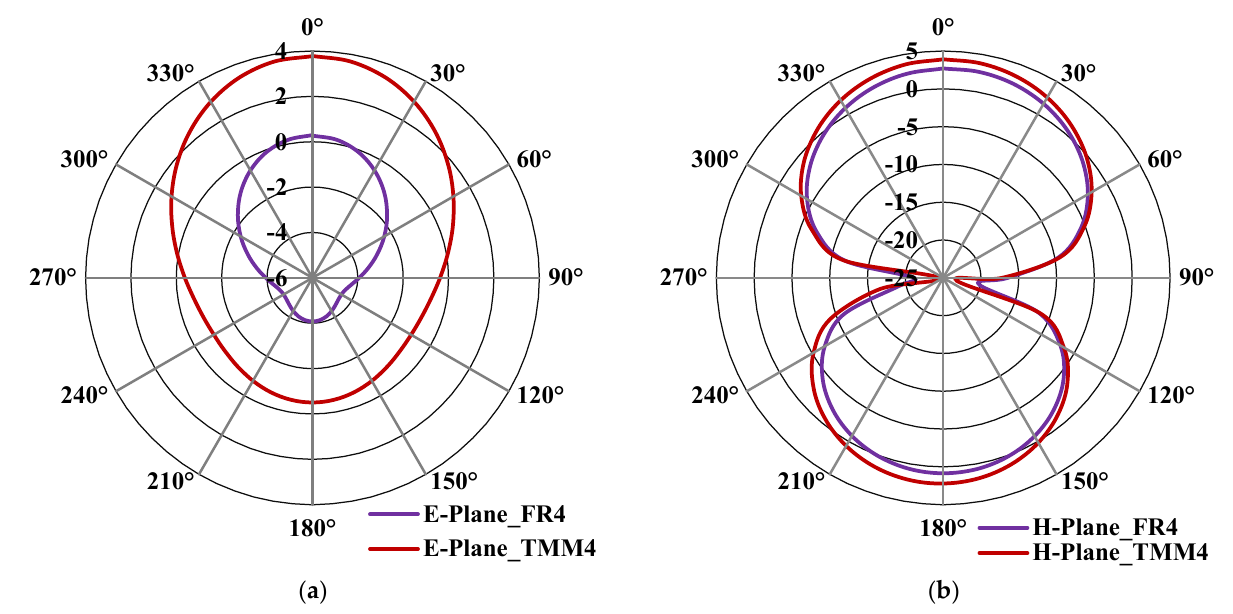
Figure 13. Simulated radiation pattern of the proposed antenna with cross-slot MTM structure etched in the ground plane at 3.5 GHz ( a ) E-plane ( b ) H-plane.